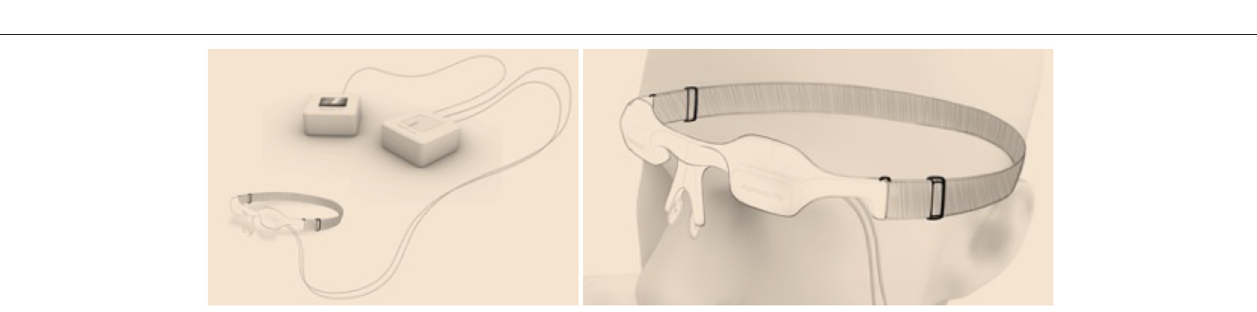
FIGURE 5 | Left: The brush robot at NatMEG (Karolinska Institutet, Stockholm, Sweden) used to study gentle touch, that is, slowly conducting tactile (CT) fibers (57). Right: The brush robot uses similar PAMs as the PAM stimulator as the device in the Figure 4 . Note that the computer-controlled device contains two PAMs for lifting and moving the brush, load cell to measure the force applied on the skin, accelerometer to monitor the movement, and two multifilament optic fibers to pick up the velocity of the brush movement and skin contact of the brush.